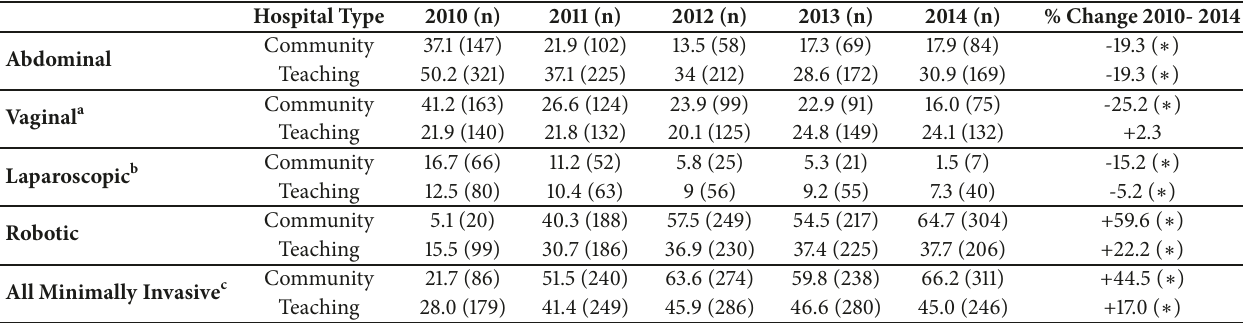
Box 1: Robotics curriculum. Table 1: Percent of hysterectomies by route-by